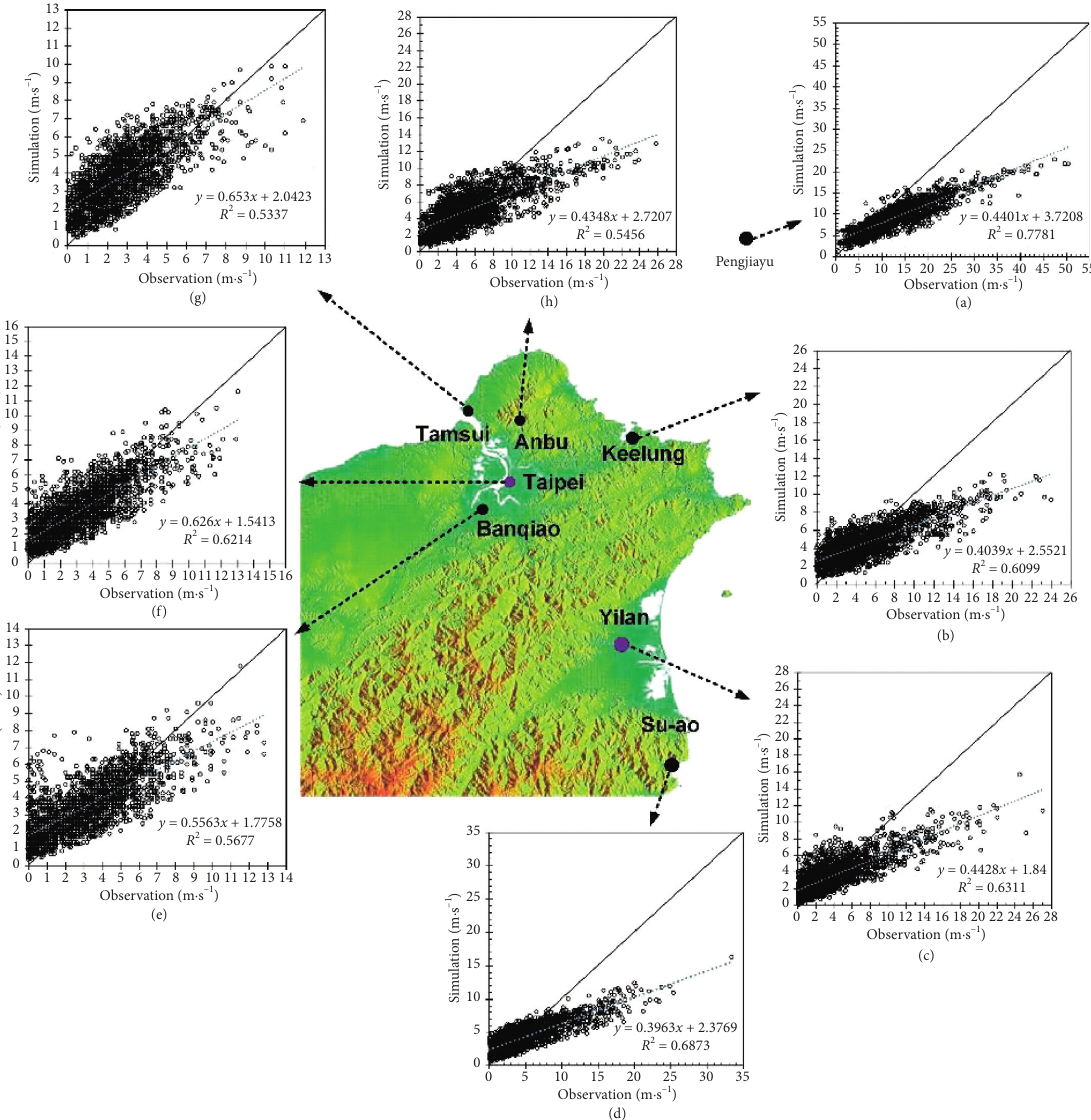
Figure 5: Scatterplots depicting observations vs. WRF simulations at eight stations: (a) Pengjiayu, (b) Keelung, (c) Yilan, (d) Su-ao, (e) Banqiao, (f) Taipei, (g) Tamsui, and (h)